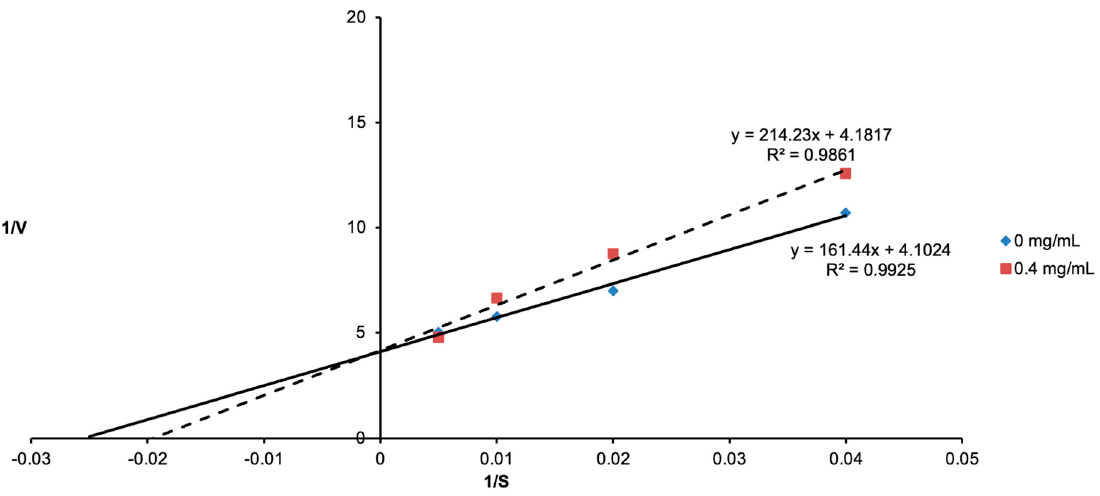
Figure 5. Lineweaver-Burk plot of conversion of L-DOPA to dopachrome by tyrosinase in the presence and absence of chlorogenic acid.